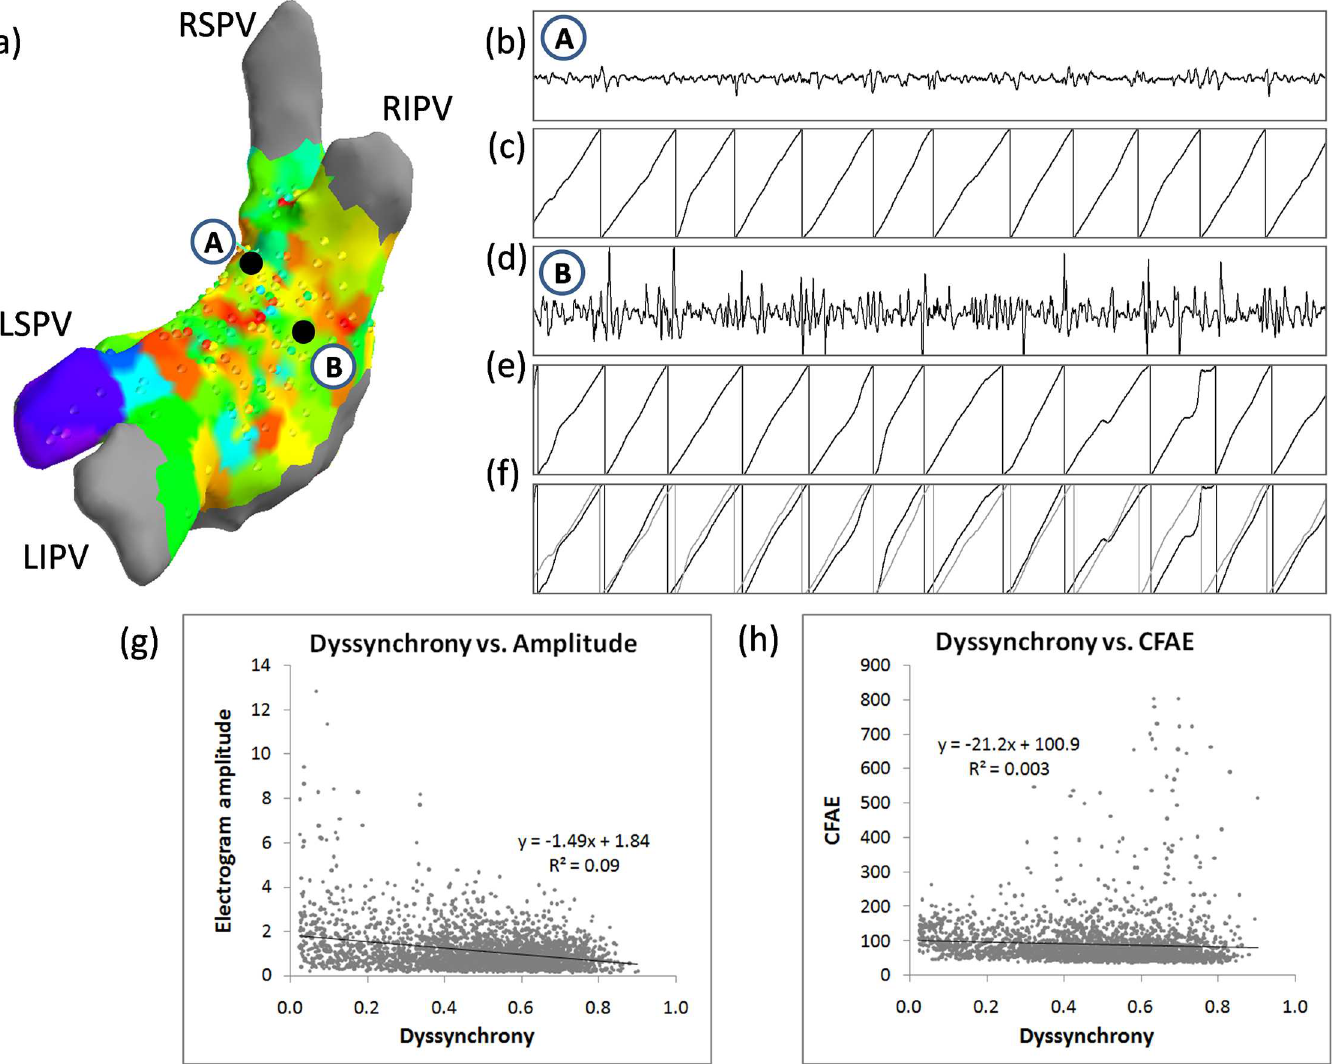
Fig 5. Correlation of dyssynchrony and electrogram amplitude and fractionation. An example of low voltage electrogramand fractionated electrogram havinga low degree of dyssynchrony (0.46 for full 8 s segment). (a) Locationsof the points on the LA geometry. (b) and (d) 2 s fragments of electrograms. (c) and (e) Phases corresponding to both electrograms. (f) Superposition of the phases of both electrograms showinga high degree of overlapdenoting low dyssynchrony. (g) The relationshipbetween dyssynchrony and electrogram amplitudefor all data points. (g) The relationship between dyssynchrony and electrogramfractionation for all data points (N =